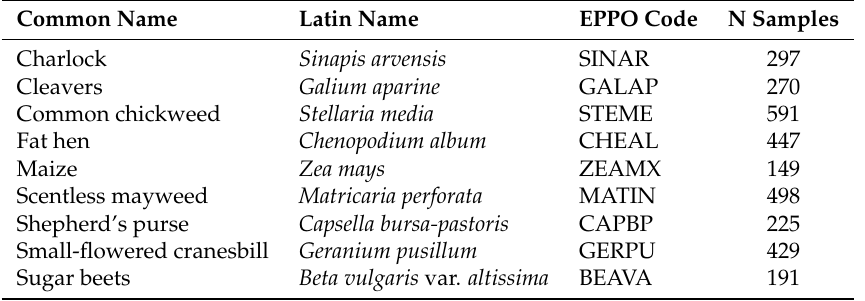
Table 1. Overview of data in sPSD after removing grass species and images with a resolution larger than 400 pixels in either